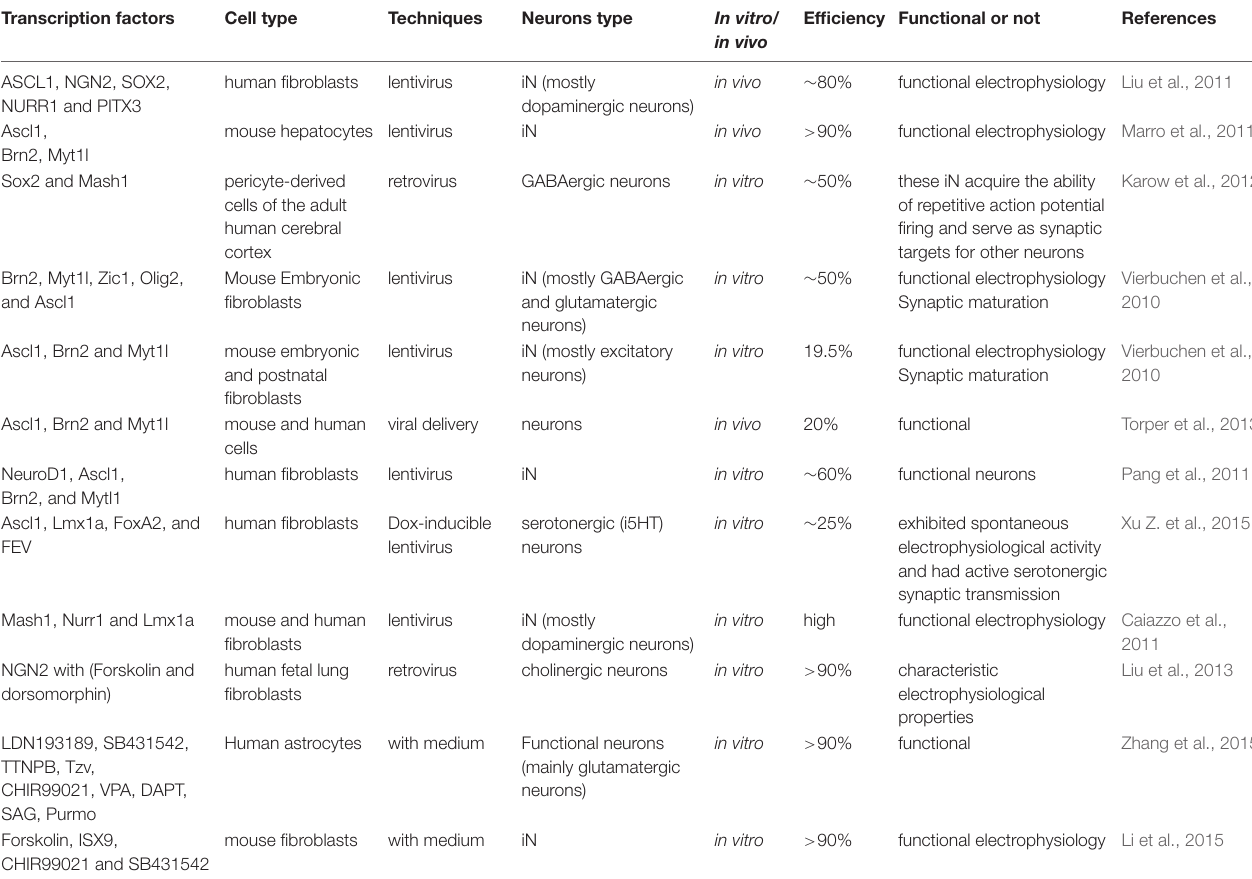
TABLE 2 | Neurons derived from direct reprogramming